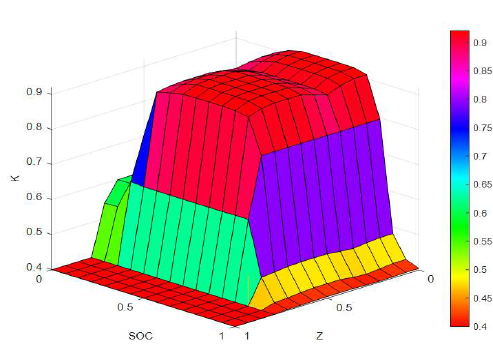
Figure 12. Relationship between K , Z, and SOC.